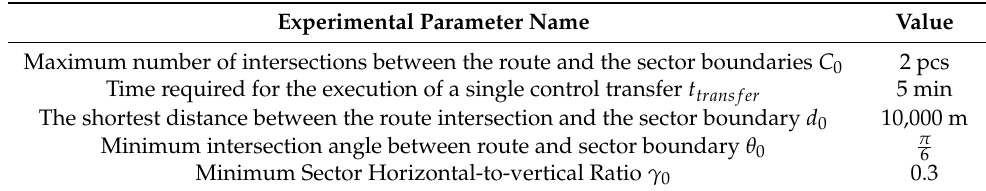
Table 2. Experimental parameters setting.